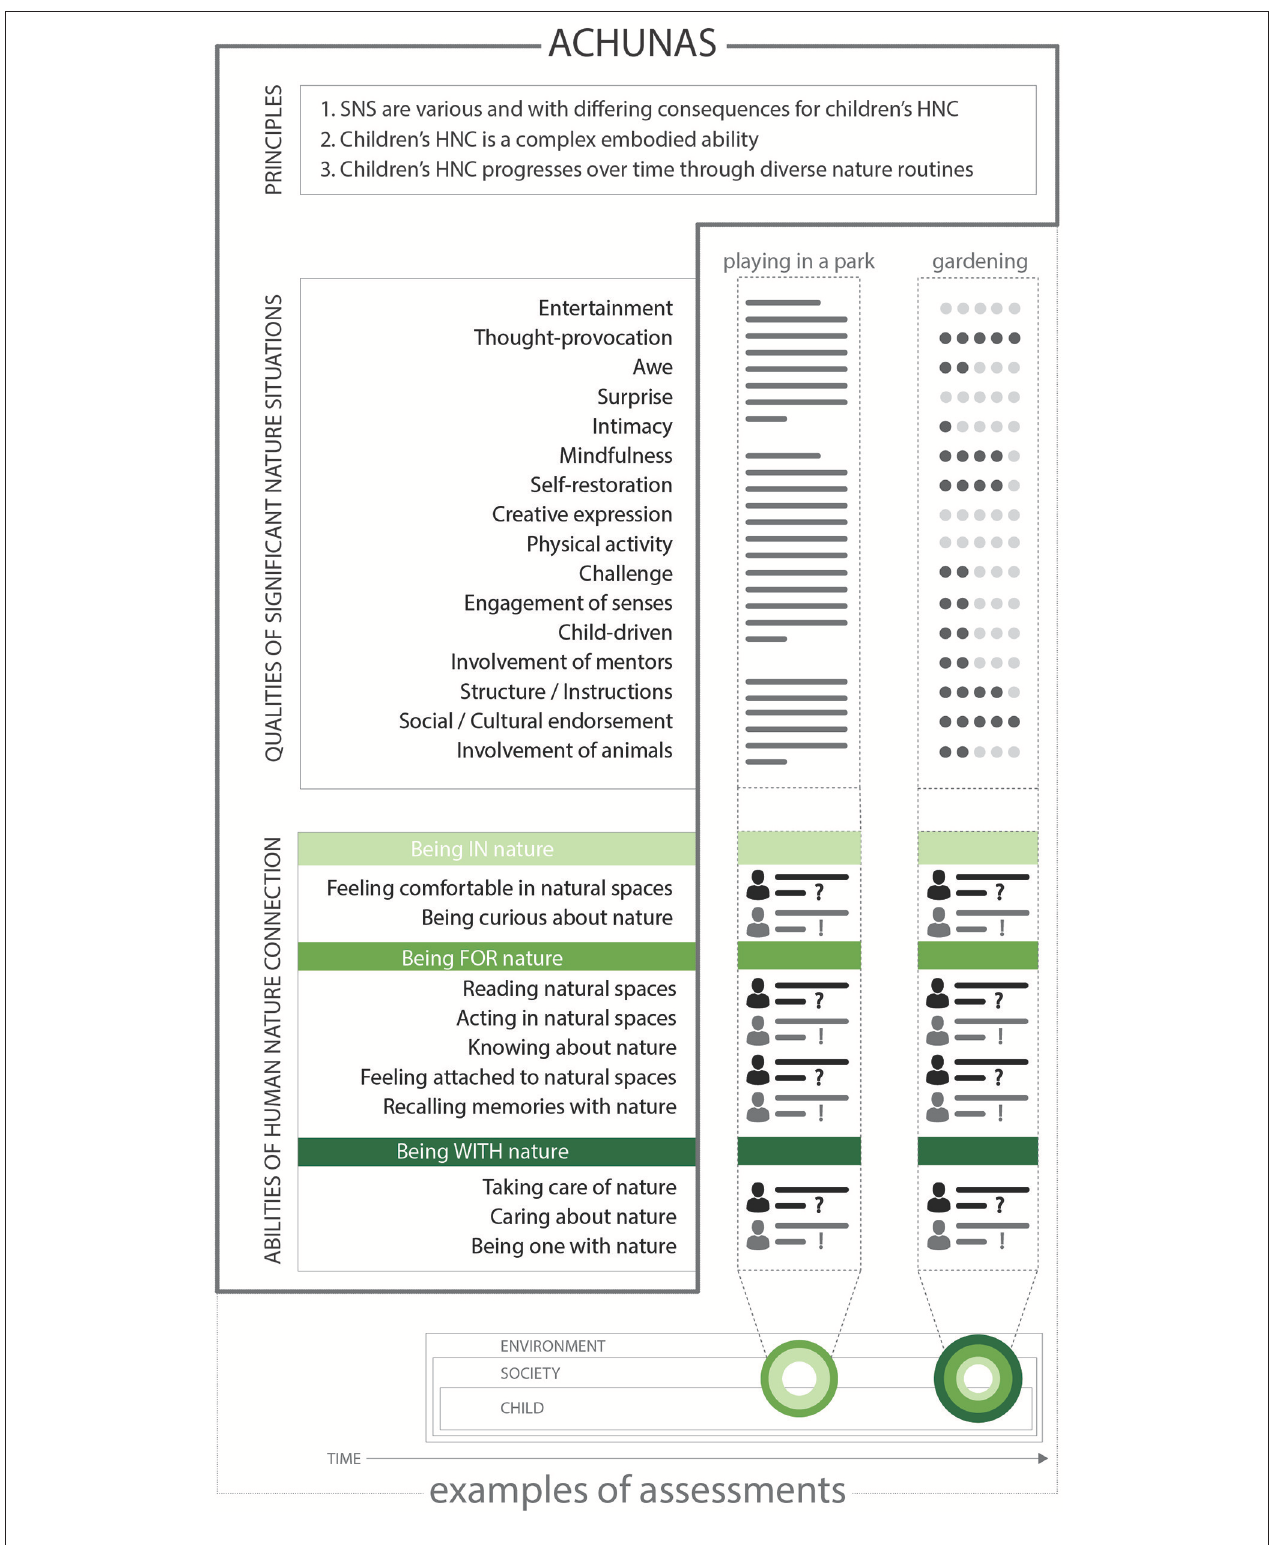
FIGURE 6 | Assessment framework for Children’s Human Nature Situations (ACHUNAS). ACHUNAS comprises the list of qualities of SNS, the list of children’s abilities of human-nature connection, and three guiding principles. The figure shows the hypothetical assessment of two SNS (playing in the park and gardening) with different configurations of qualities of SNS and abilities of